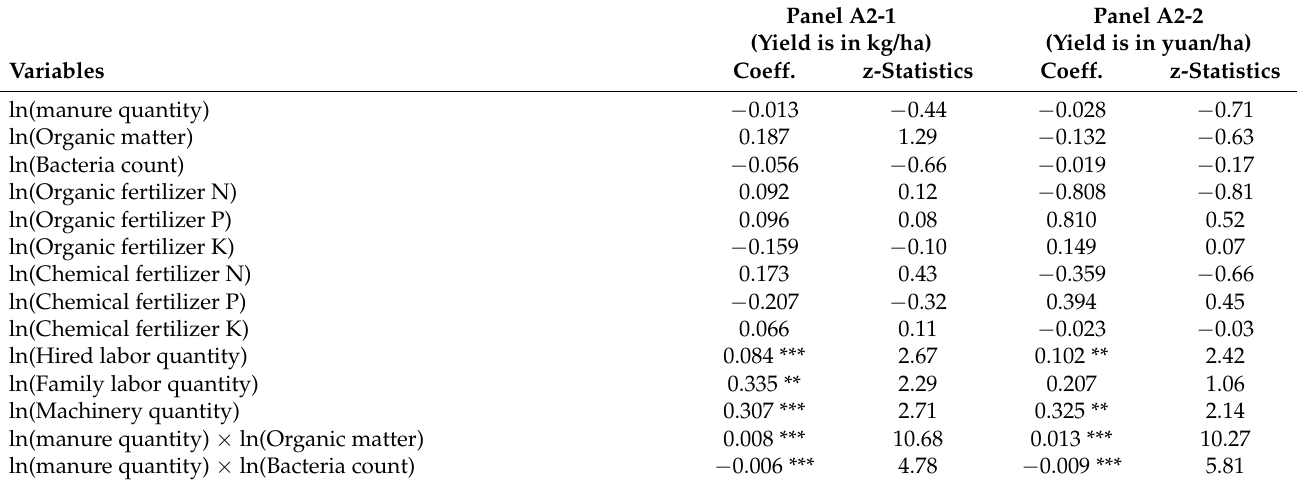
Table A2. Production function estimation results with inputs measured in physical